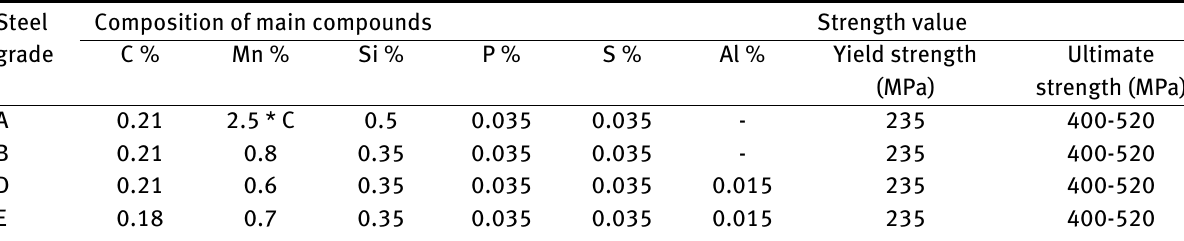
Table 1: IACS requirements for material specification